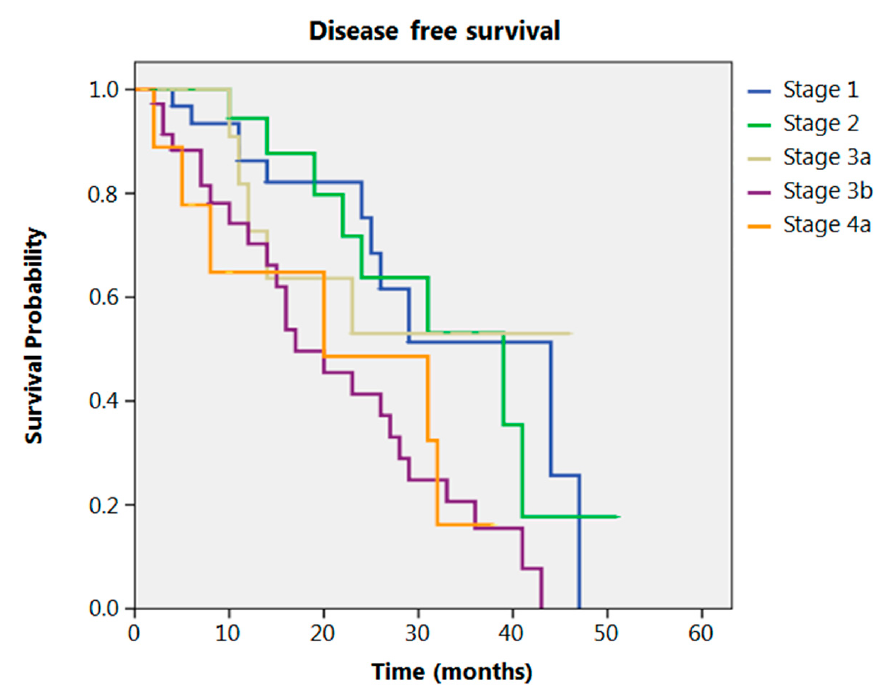
Figure 3 . Disease free survival according to yp stage . Figure 3. Disease free survival according to yp stage.